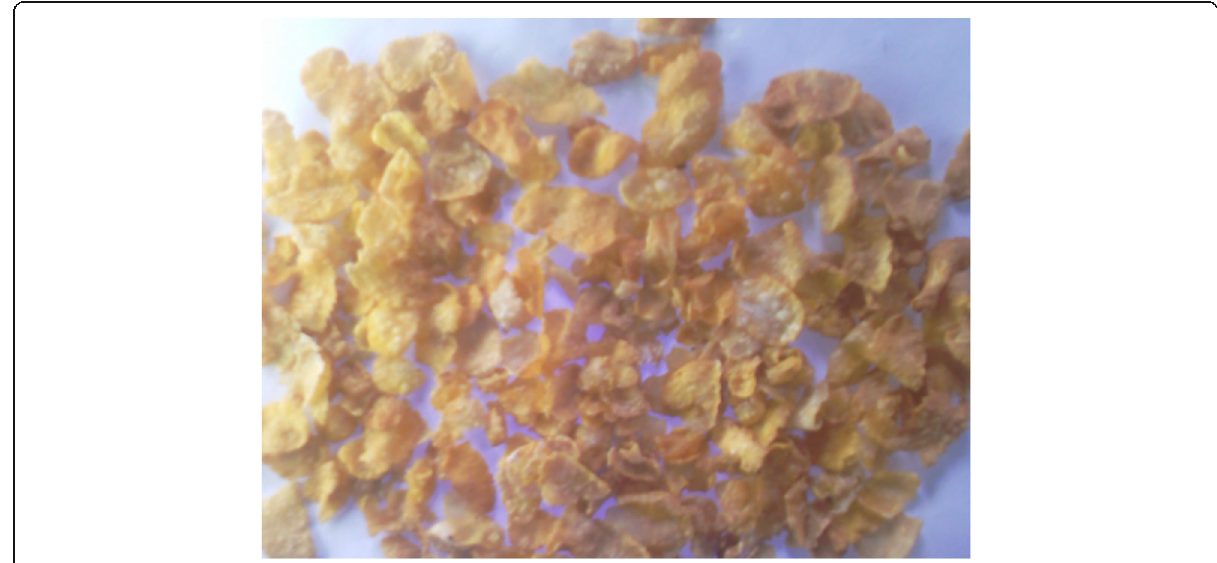
Fig. 1 Consumer-ready flakes produced at optimal